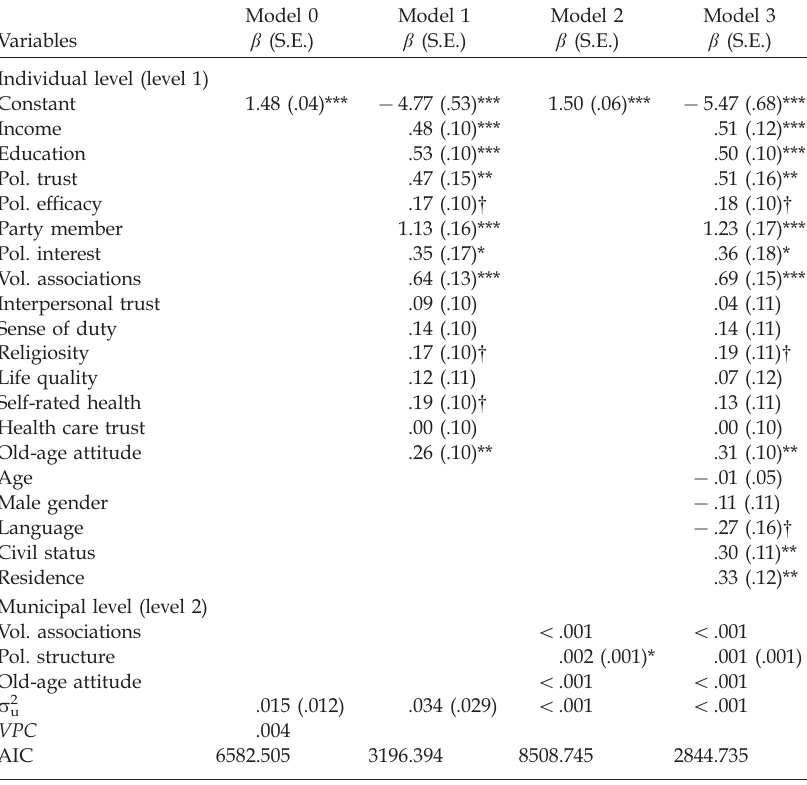
Table 4. The effect of indi v idual- and municipal-le v el v ariables on v